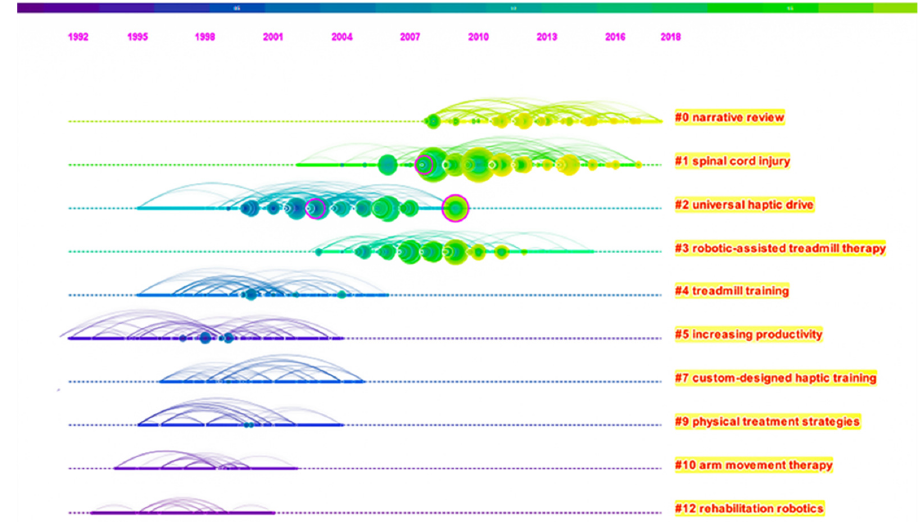
Figure 5. Timeline view clusters of document co-citation. The colors represent the articles’ publication years.